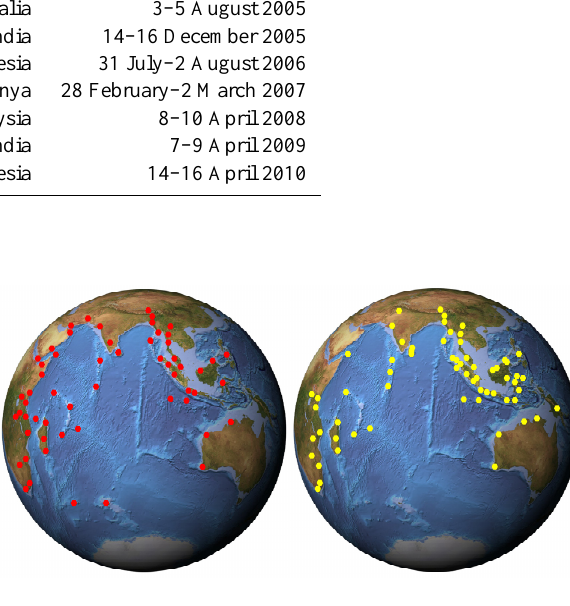
Fig. 1. Recommendation of Working Group 1 for the establishment Figure 1: Recommendation of Working Group 1 for the establishment of an Indian of an Indian Ocean wide seismic network. Left: plan developed in Ocean wide seismic network. 2005. Right: status of the network in Left: Plan developed in 2005. Right: Status of the network in 2010.